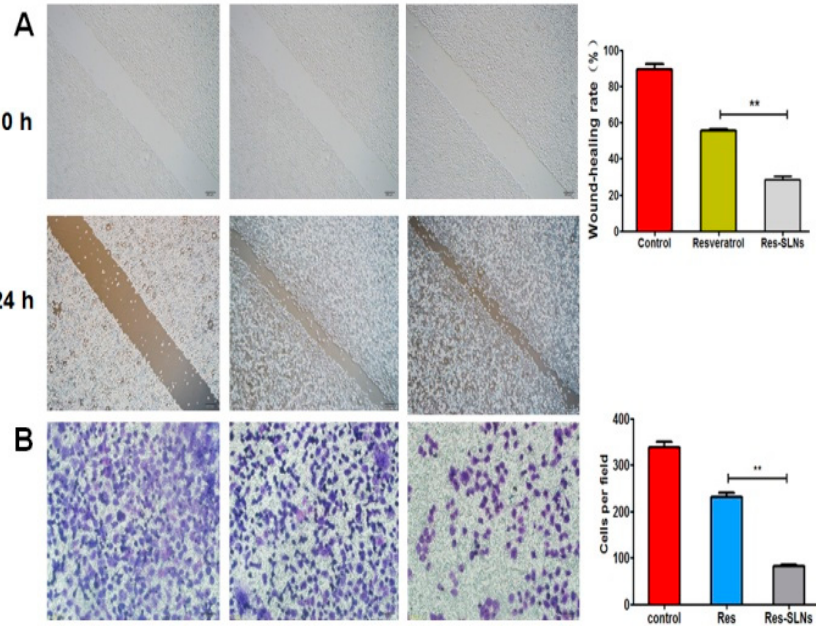
Figure 6. The suppression of MDA-MB-231 cell migration and invasion in vitro by Resveratrol-SLNs. ( A ) The effect of Resveratrol and Resveratrol-SLNs on cell migration measured by wound healing assay; ( B ) Cell invasiveness measured by Matrigel transwell invasion assays after incubation with Resveratrol and Resveratrol-SLNs for 24 h. Bars represent mean ± S.D. and asterisks denote a significant difference (** P < 0.01).